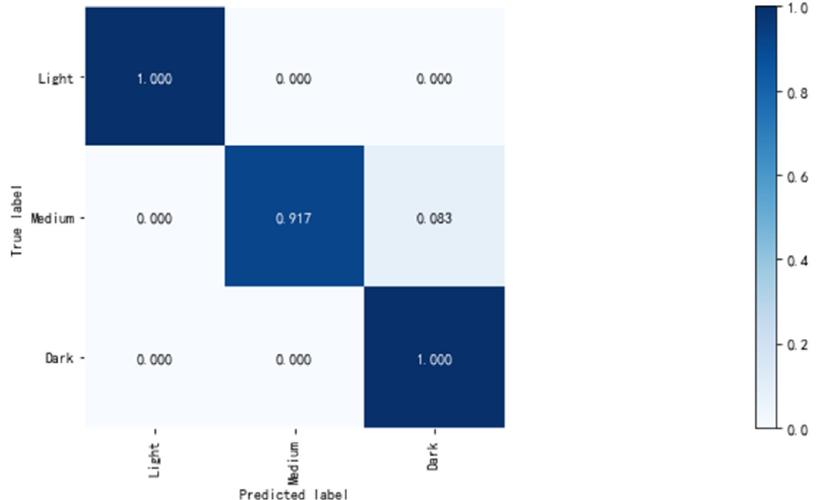
Figure 5. XGBoost classification confusion matrix.